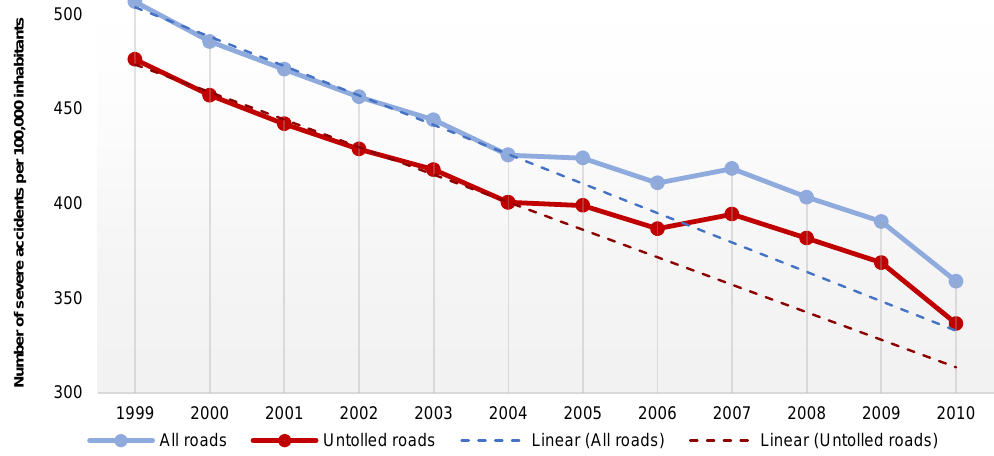
Figure 2. Mean of the number of accidents with damage to persons (all roads and non-tolled roads) per 100,000 inhabitants between 1999 and 2010 in